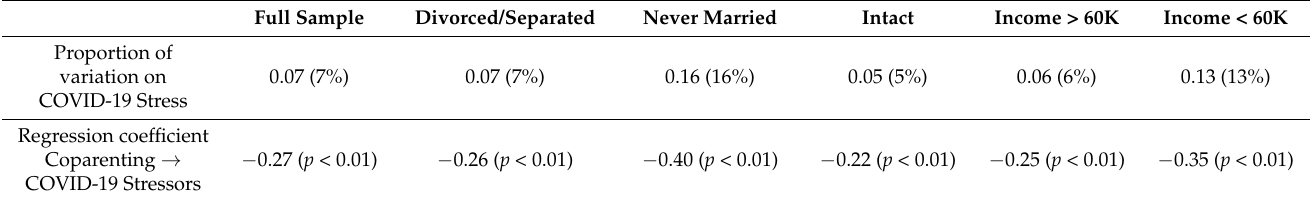
Table 4. Predicting COVID-19-related stress for the 6